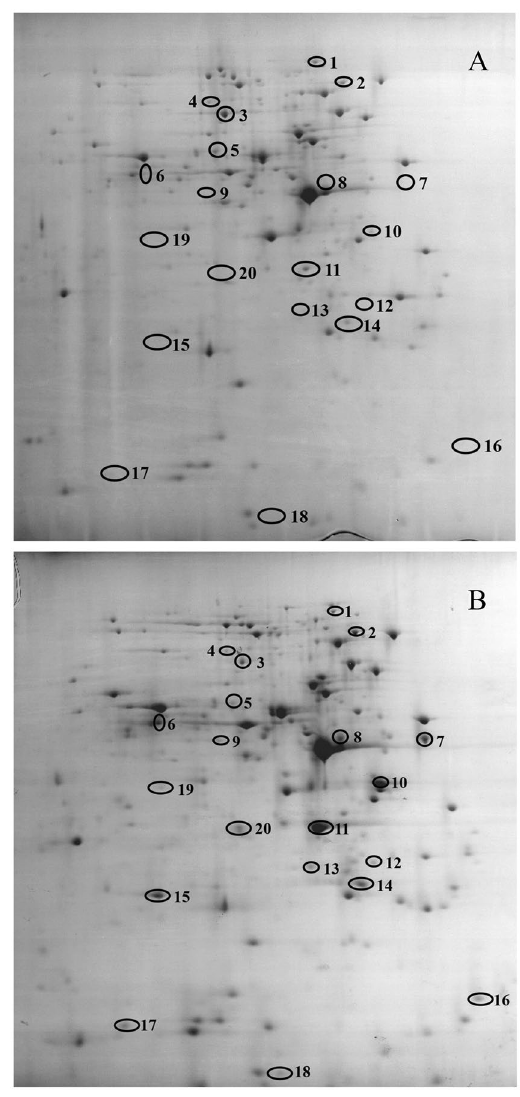
Figure 6. 2-D PAGE gels of soluble proteins from Acinetobacter sp. DW-1 cells grown in MSM supplemented with 4 mM acetate ( A ) or 4 mM acetate and 4 mM phenol ( B ). pH 4–7 (from right to